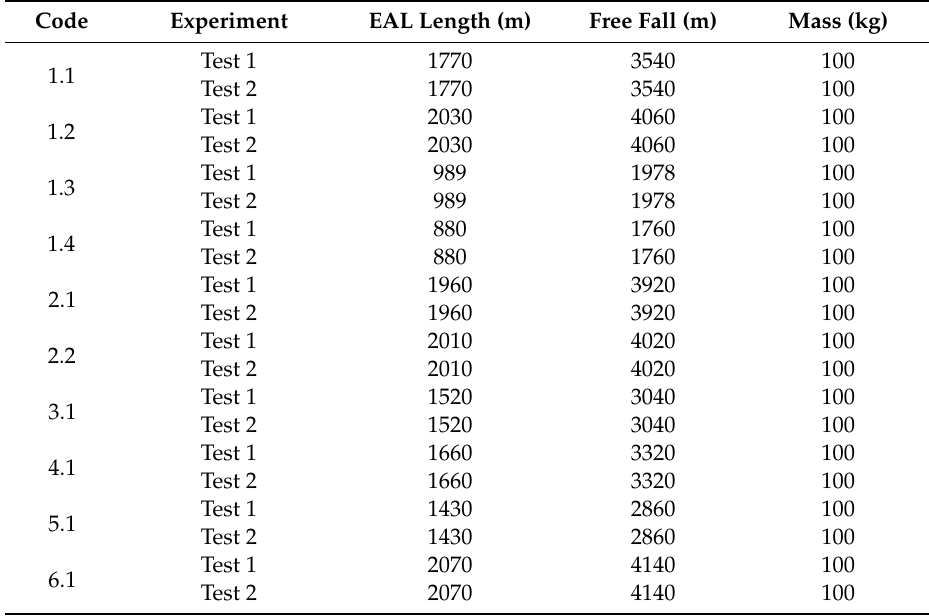
Table 3. Independent variables for each